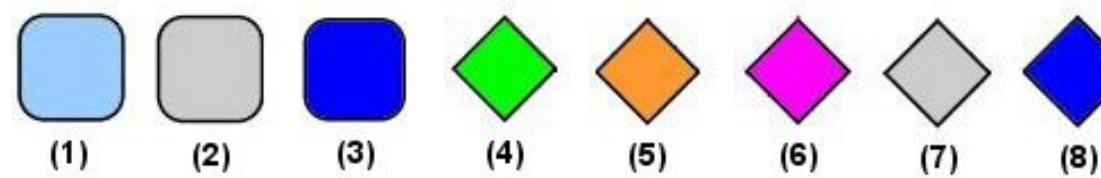
Figure 3: Node types defined by the DomainGraph Visual Style: (1) normally expressed protein, (2) suppressed protein, (3) protein combination, (4) normally expressed domain, (5) indirectly a ff ected domain, (6) spliced domain, (7) suppressed domain, and (8) domain combination.